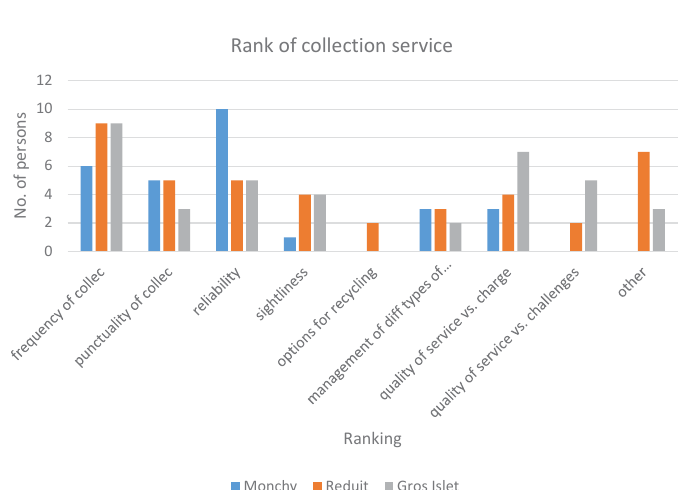
Fig. 5: Factors affecting residents rank of adequacy of garbage collection service